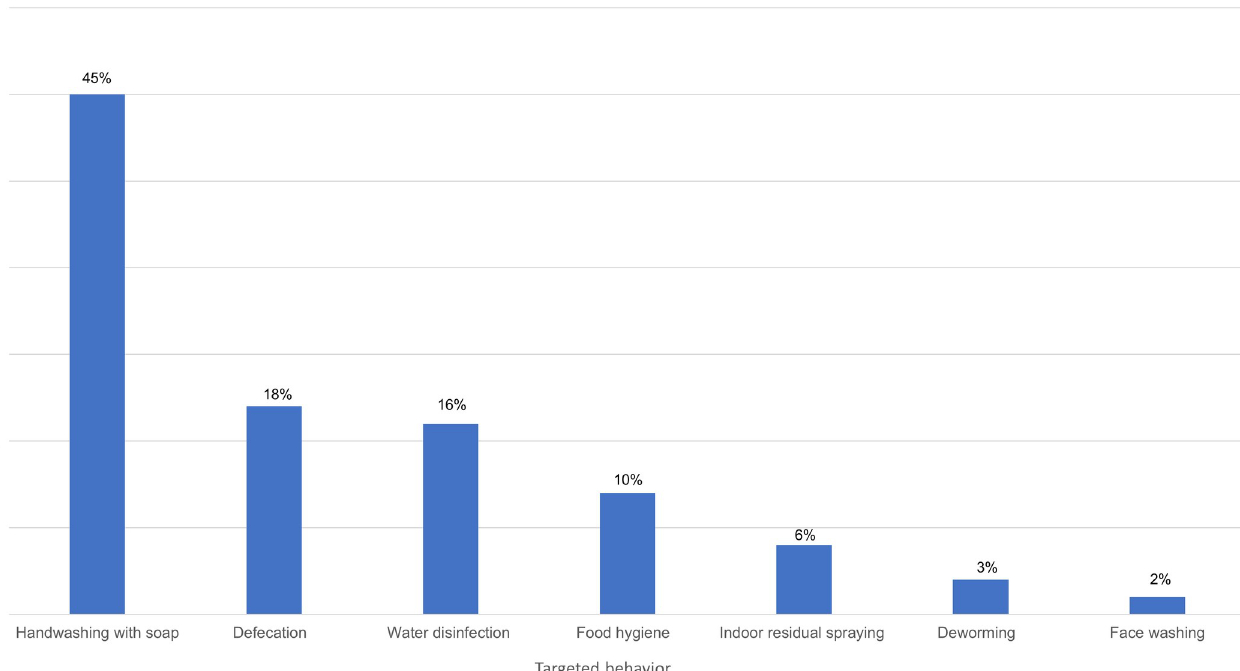
PLOS NeglectedTropical Diseases | https://doi.org/10.1371/journal.pntd.0009239 November1,